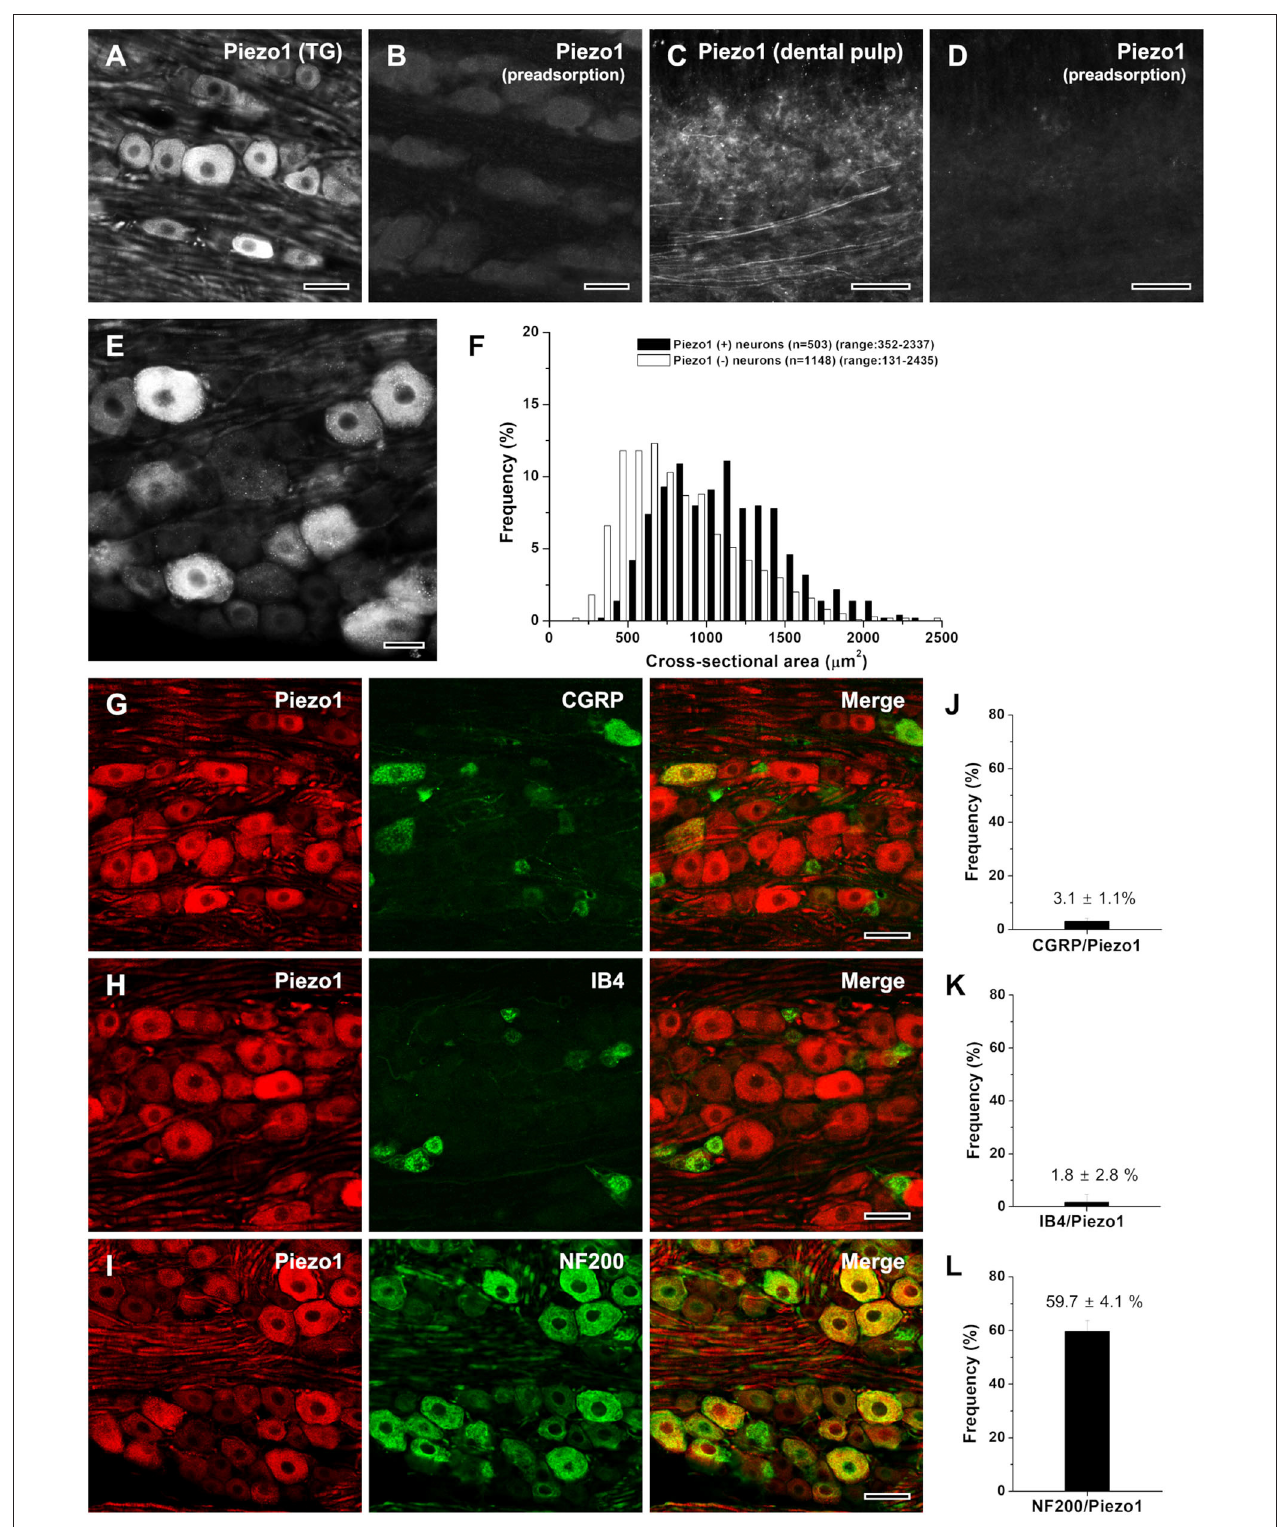
FIGURE 1 | Light micrographs showing the specificity of Piezo1 immunostaining in the rat trigeminal ganglion [TG; (A,B) ] and the human dental pulp (C,D) , the size distribution (E,F) , and the neurochemical characterization (G–L) of Piezo1 + neurons in the rat TG. (A–D) Immunofluorescent staining for Piezo1 in the rat TG (A,